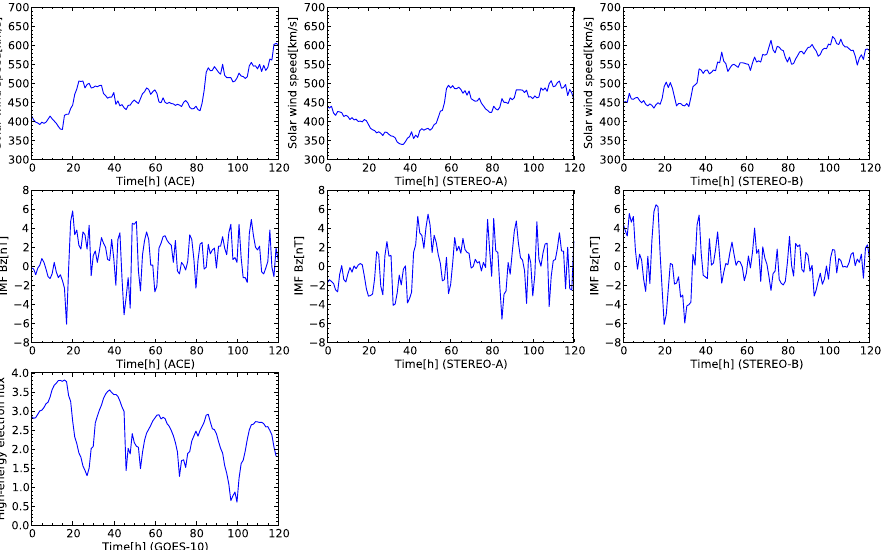
Figure 10. Time development of sensor data for five days from 30 April 2008 at 00:00:00 UTC. This plot contains an event of high-speed solar wind flowing from a coronal hole. In the first and second rows, the plots of the columns correspond to the satellites of ACE, STEREO-A, and STEREO-B, respectively. In the third row, the plot corresponds to